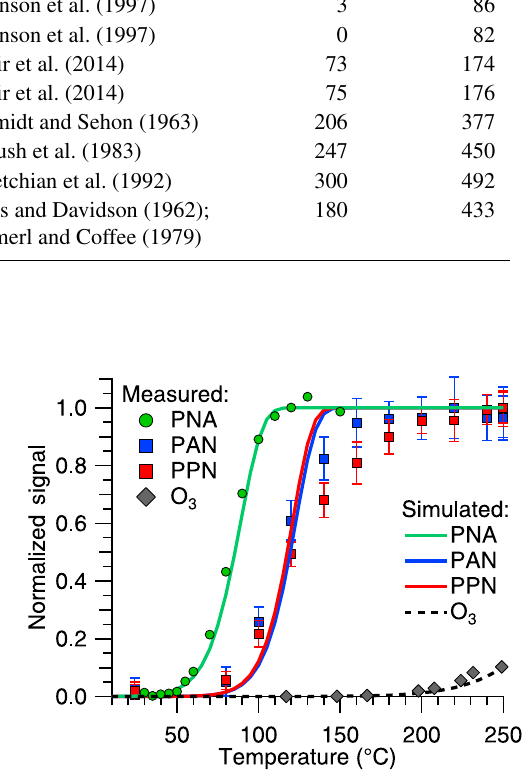
Table 4. Arrhenius parameters for thermal dissociation of selected PN, PAN, PPN, PAA, and O 3 . Molecule A (s − 1 ) E a (kJmol − 1 ) Reference T needed to T needed HO 2 NO 2 (PNA) 7.3 × 10 14b 88.1 ± 4.4 Atkinson et al. (1997) 24 123 CH 3 O 2 NO 2 (MPN) 1.1 × 10 16